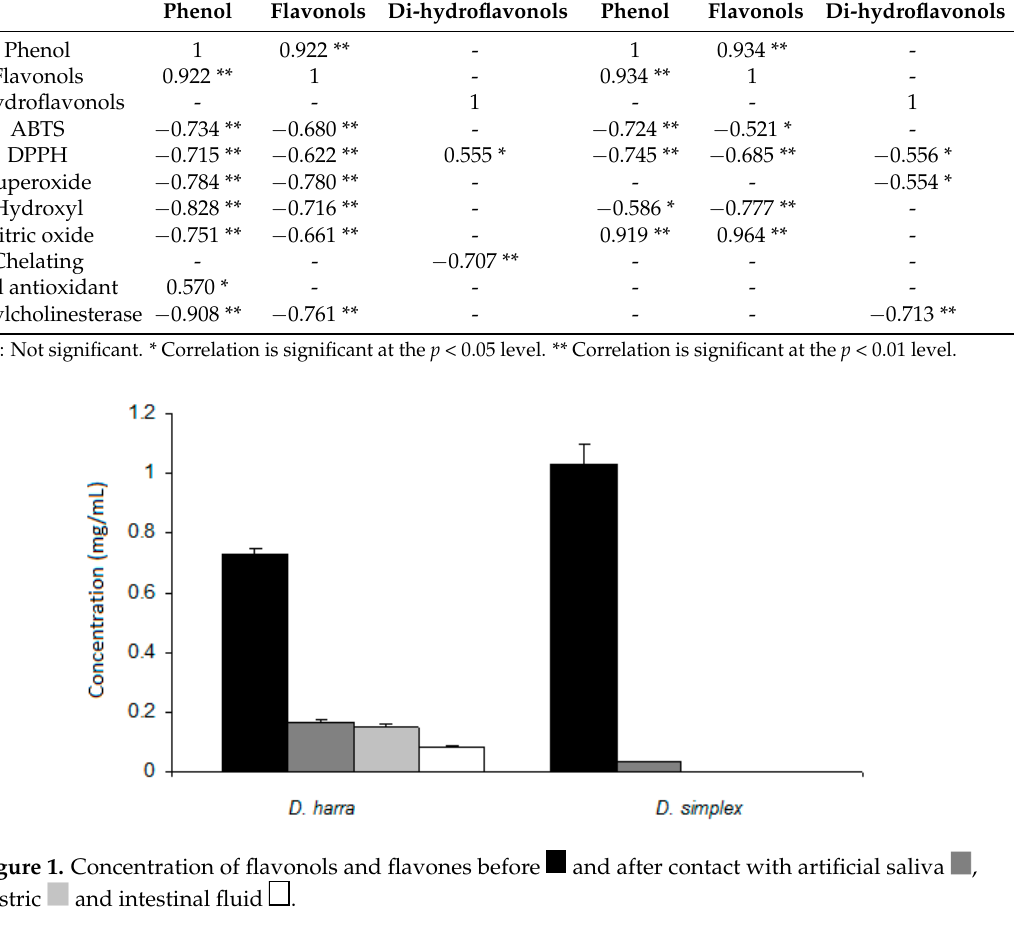
Table 4. Pearson correlation coefficients among compounds and antioxidant activities.